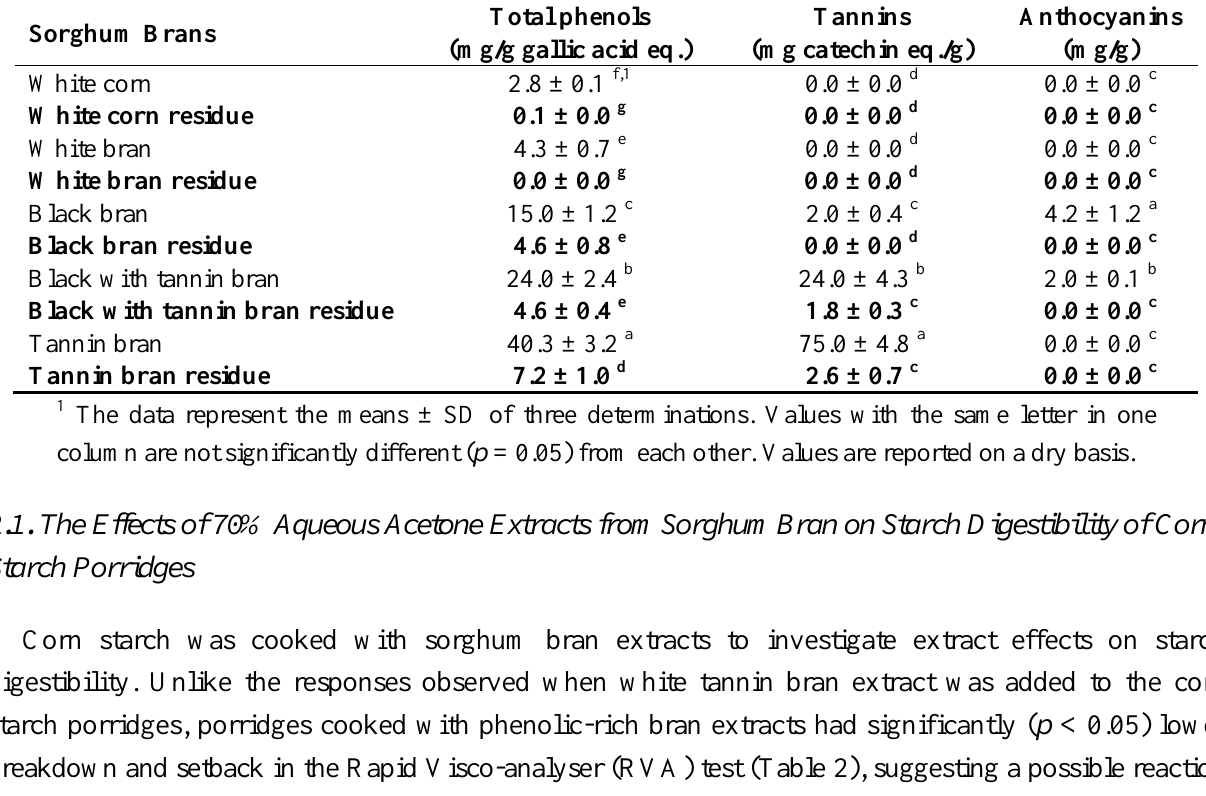
Table 1. Total phenol and tannin contents of sorghum brans before and after extraction (residues). Sorghum